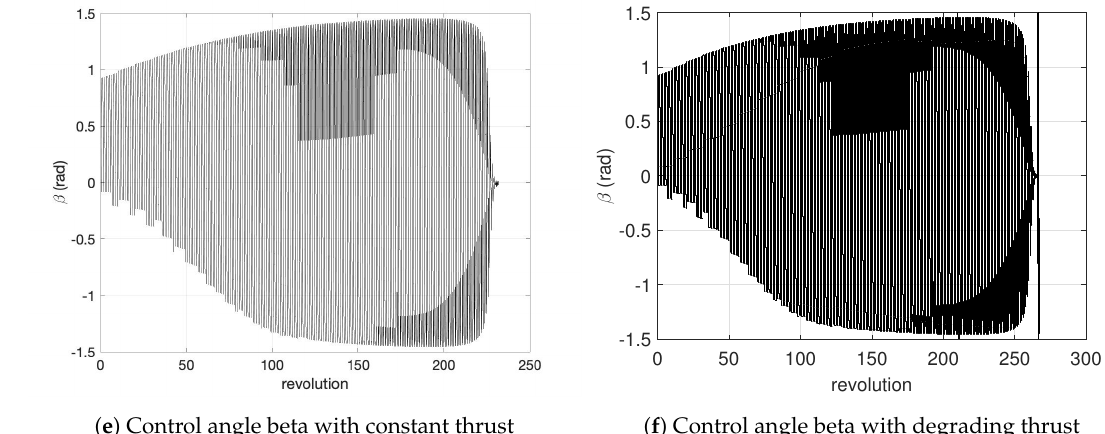
Figure 15. Trajectory and control angles of GTO-GEO with coasting